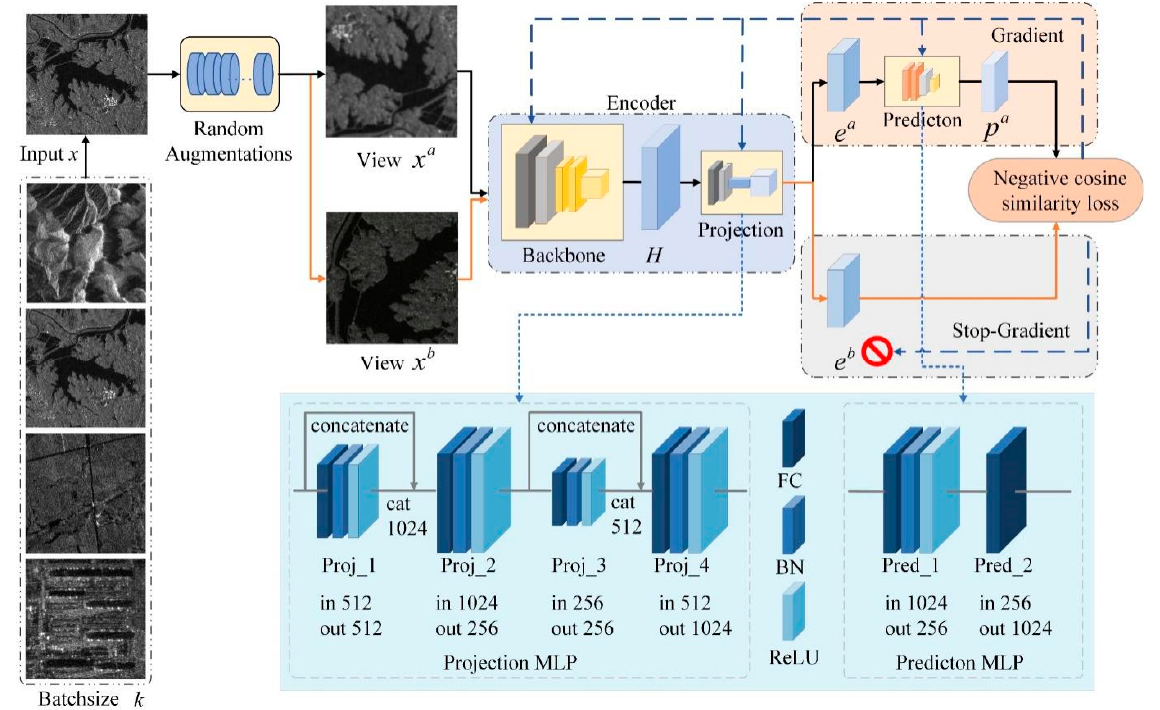
Figure 2. Network structure.